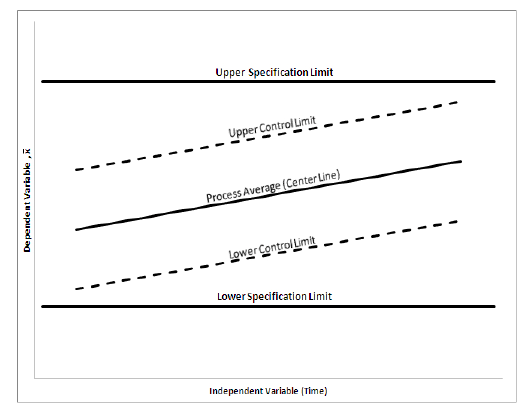
Fig 2. Schematic representation of regression control